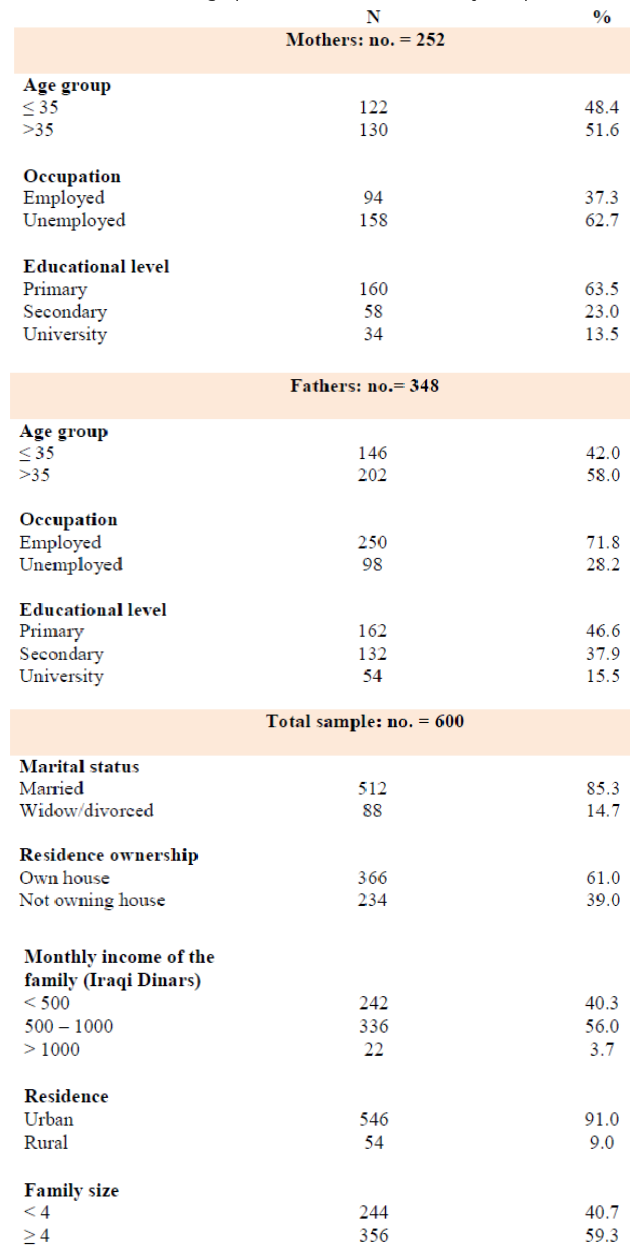
Table (1): Socio-demographic characters of the study